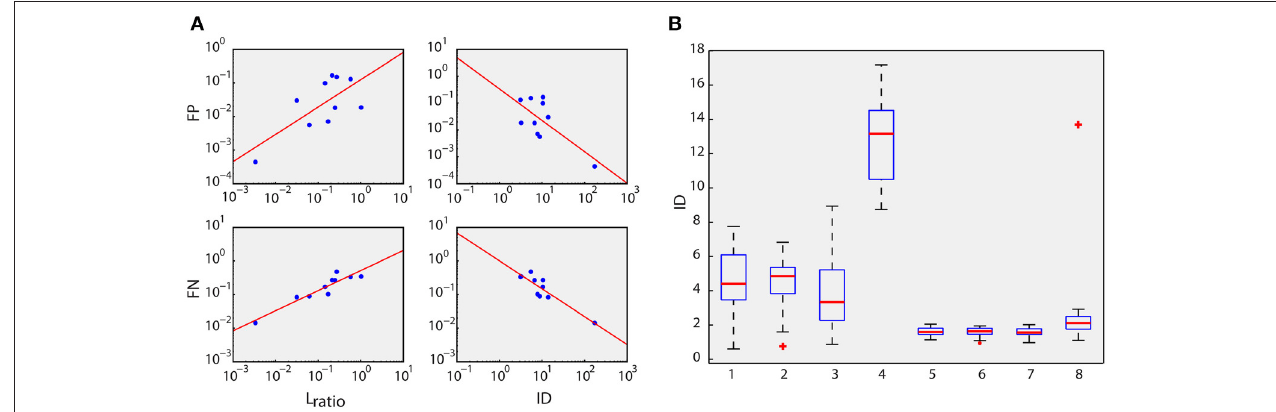
FIGURE 3 | Feature space evaluations. (A) Type I (False Positives, FP) and type II (False Negatives, FN) error rates against L ratio and Isolation Distance (ID) measures (Schmitzer-Torbert et al., 2005) in the log scale of 10 different datasets of real data. Linear correlations are significant (Pearson Correlation, p < 0.05 ). (B) ID between and within clusters of the simulated dataset (Materials and Methods). Boxplots 1, 2, 3, and 4 depict the IDs of the clusters of neurons 1, 2, 3 and falsely detected spikes (see Figure 2D ), respectively, from the other clusters (between-cluster IDs). Boxplots 5, 6, 7, and 8 are the IDs of the clusters of neurons 1, 2, 3, and falsely detected spikes from the corresponding cluster itself (within-cluster IDs). All comparisons (ANOVA) of four pairs of within- and between-cluster IDs, e.g., pair 1 and 5, reveal high statistical significance ( p ≪ 0.001 ).